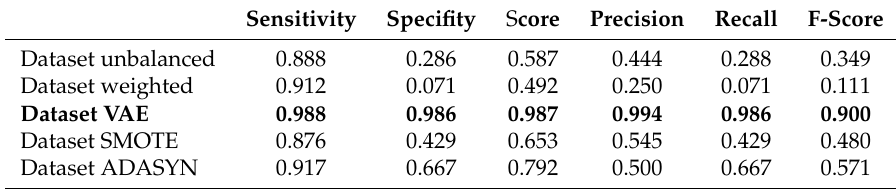
Table 8. Metric results obtained with the three classifications over pathologies